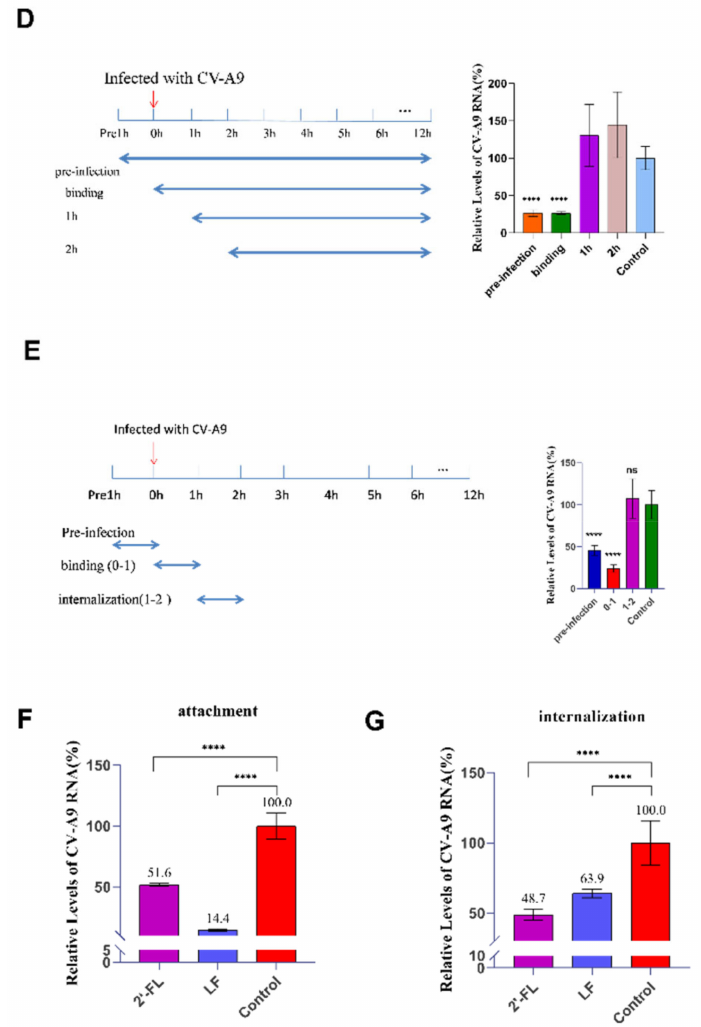
Figure 5. 2’-FL inhibits CV-A9 infection by blocking viral cell entry. ( A ) Time-of-addition experiment of 2’-FL (10 mg/mL). The detailed steps for the time-of-addition experiment were described in the method section, the viral and GAPDH mRNA levels in the infected cell were quantified using qRT-PCR at 24 h.p.i. The viral load in the supernatant was measured by plaque assay. Time course curve ( B ) and single-step growth curve ( C ) of CV-A9 production (top) in RD cells with or without a single dose of 2’-FL (10 mg/mL) or LF (0.156 mg/mL) treatment after 2 h.p.i. Supernatant and cells were harvested at 4, 6, 10, 12, 24, 36, and 48 h.p.i. for qRT-PCR. Plaque assay corresponding to the CV-A9 single-step growth curve (bottom). ( D , E ) Illustrates the time periods when 2’-FL was present in the cell culture. The arrows indicate the time period 2’-FL (10 mg/mL) exists in the cell culture (left). RD cells were infected with CV-A9 at MOI = 5, with cells following the corresponding drug treatment. At 12 h.p.i., the viral yield in cells was quantified using qRT-PCR and normalised by GAPDH level (right). Determining the effectiveness of 2’-FL on ( F ) viral attachment and ( G ) viral internalisation. Virus infection and drug treatment were performed as mentioned above. Briefly, RD was infected with CV-A9 at 4 °C for 2 h and then at 37 °C for 1 h, allowing temperature-sensitive entry steps to proceed. p.i.: post-infection. The shown results are representative of one experiment out of at least two experiments. Data represent the mean of the three replicate results, error bars represent ± 1 SD; ns: no significant difference; **** p < 0.0001 by Student’s t -test compared with